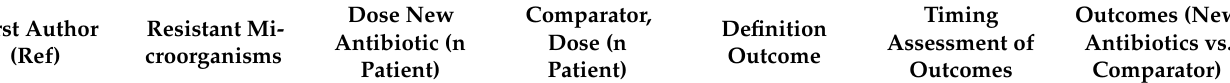
Table 4. Clinical trials in complicated urinary tract infection